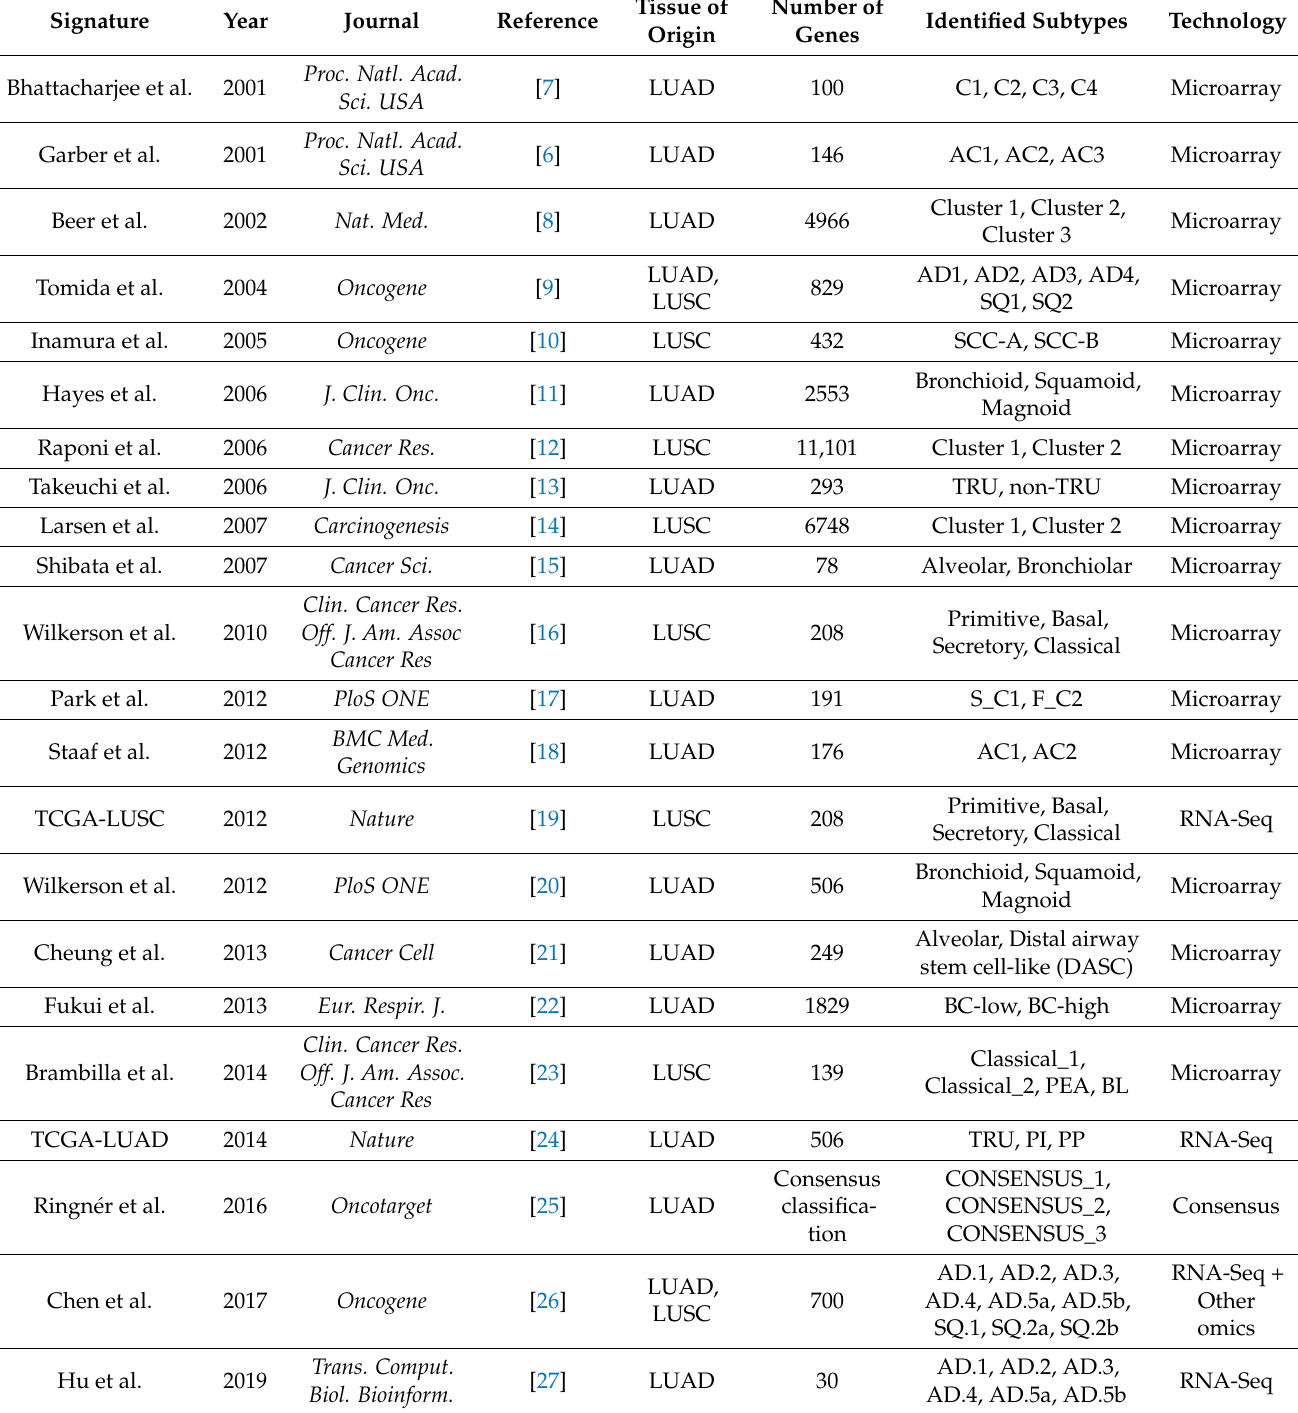
Table 1. Non-small cell lung cancer gene expression subtypes